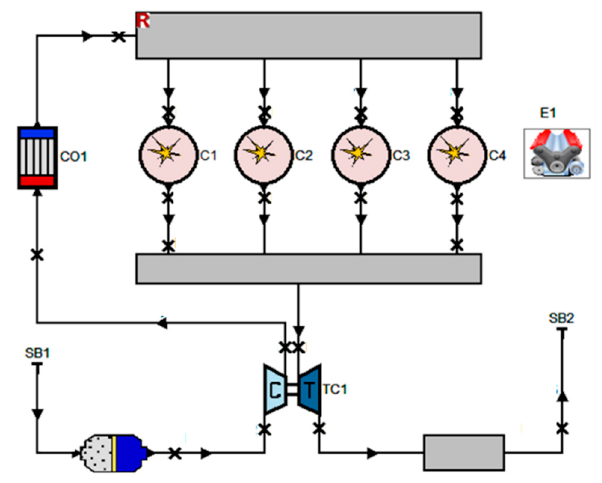
Figure 2. Development of a digital model of the engine.